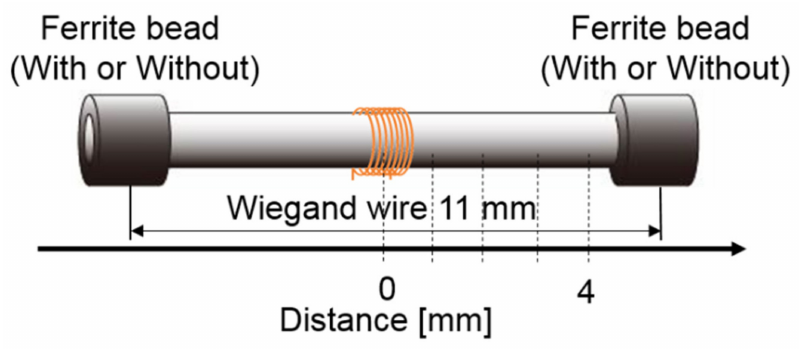
Figure 5. Schematic for position